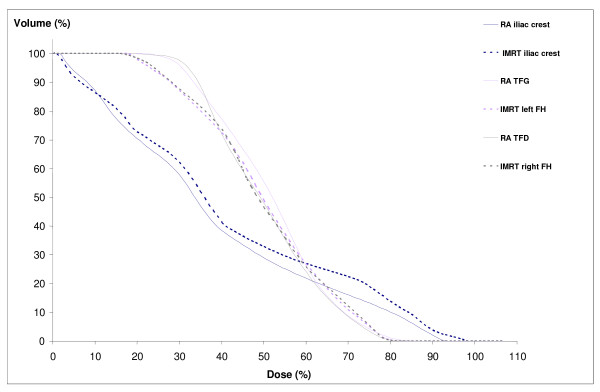
Dose-volume histograms for iliac crests and femoral heads. RA, Rapidarc; IMRT, intensity-modulated radiotherapy; FH, femoral head